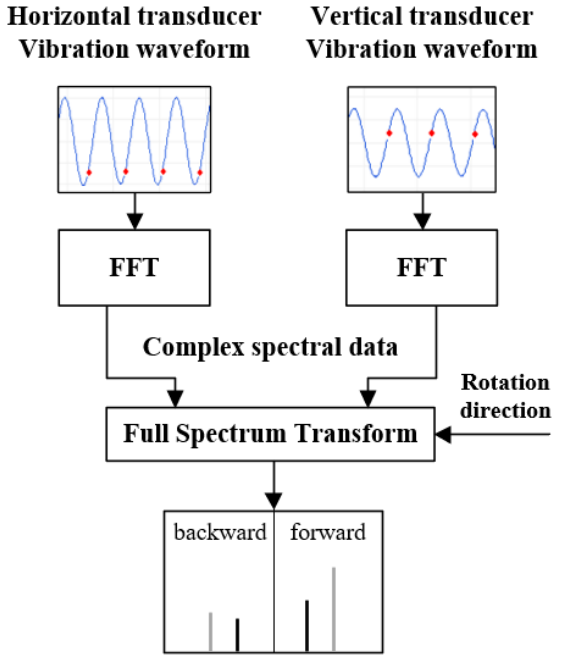
Figure 3. Schematic presentation of full-spectrum calculation.